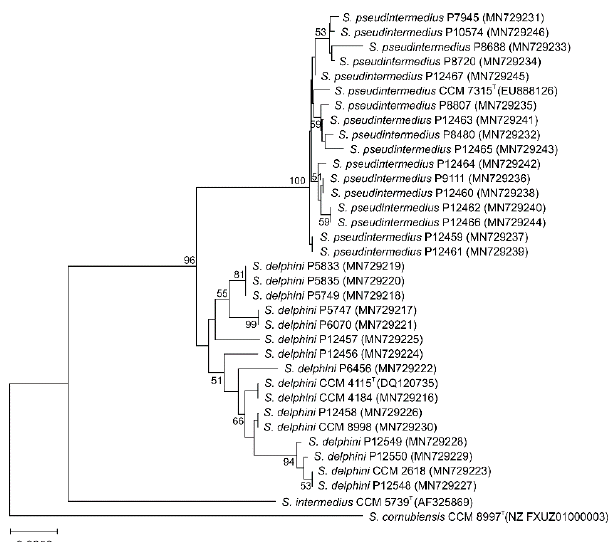
Figure 2. Unrooted neighbor-joining tree based on partial RNA polymerase beta-subunit ( rpoB ) gene sequence comparison, showing the clustering of Antarctic Staphylococcus intermedius group isolates and type and reference strains. The percentage of 500 tree replications above 50% in which the associated strains clustered together is shown next to the branches. The tree is drawn to scale, with branch lengths in the same units as those of the evolutionary distances used to infer the phylogenetic tree. The evolutionary distances were computed using the Tajima–Nei method and are in the units of the number of base substitutions per site. All ambiguous positions were removed for each sequence pair (pairwise deletion option). There was a total of 845 positions in the final dataset.